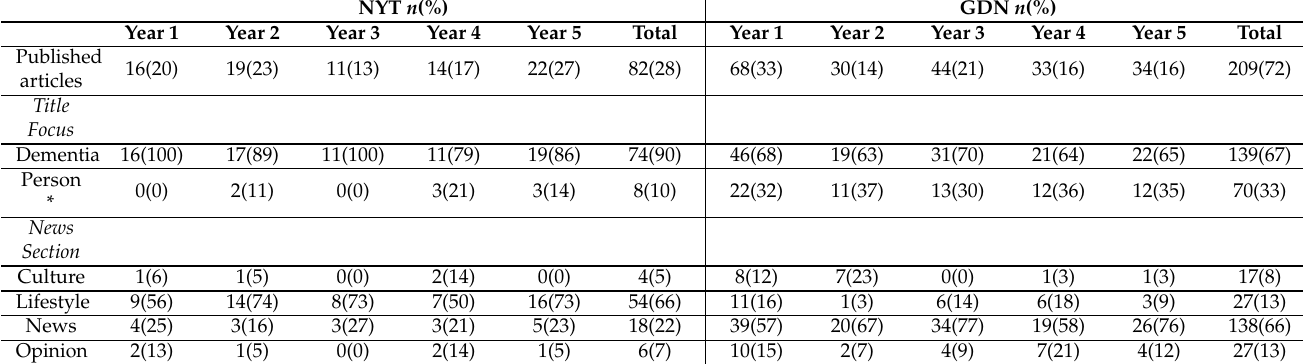
Table 1. Yearly distribution of published articles in relation to title focus and news section in NYT and